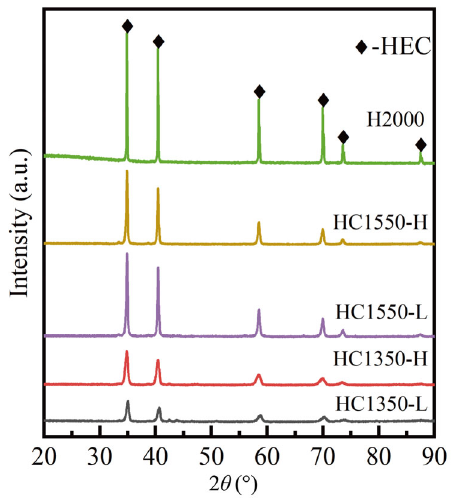
Fig. 1 XRD patterns of the as-sintered ceramics.